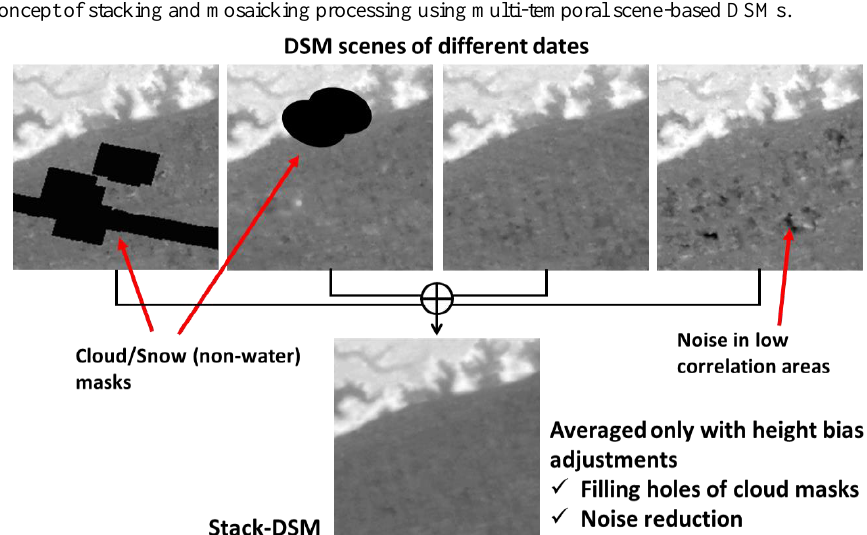
Figure 7. An example of the visual comparison between the stacked DSM and individual scene-based